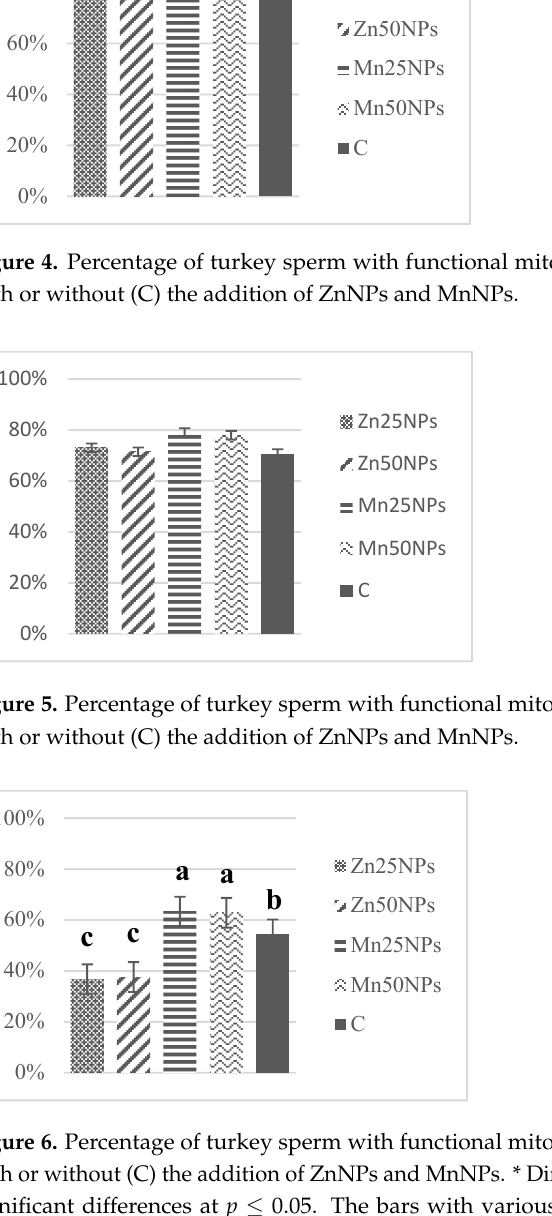
Figure 6. Percentage of turkey sperm with functional mitochondria (%) in samples stored for 48 h with or without (C) the addition of ZnNPs and MnNPs. * Different letters (a, b, c) indicate statistically significant differences at p ≤ 0.05. The bars with various letters are significantly different from one another.